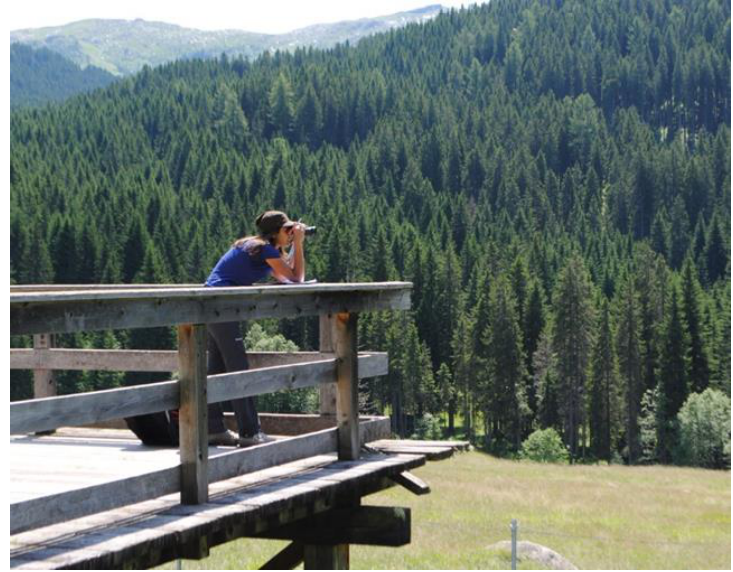
Figure 2. Observation